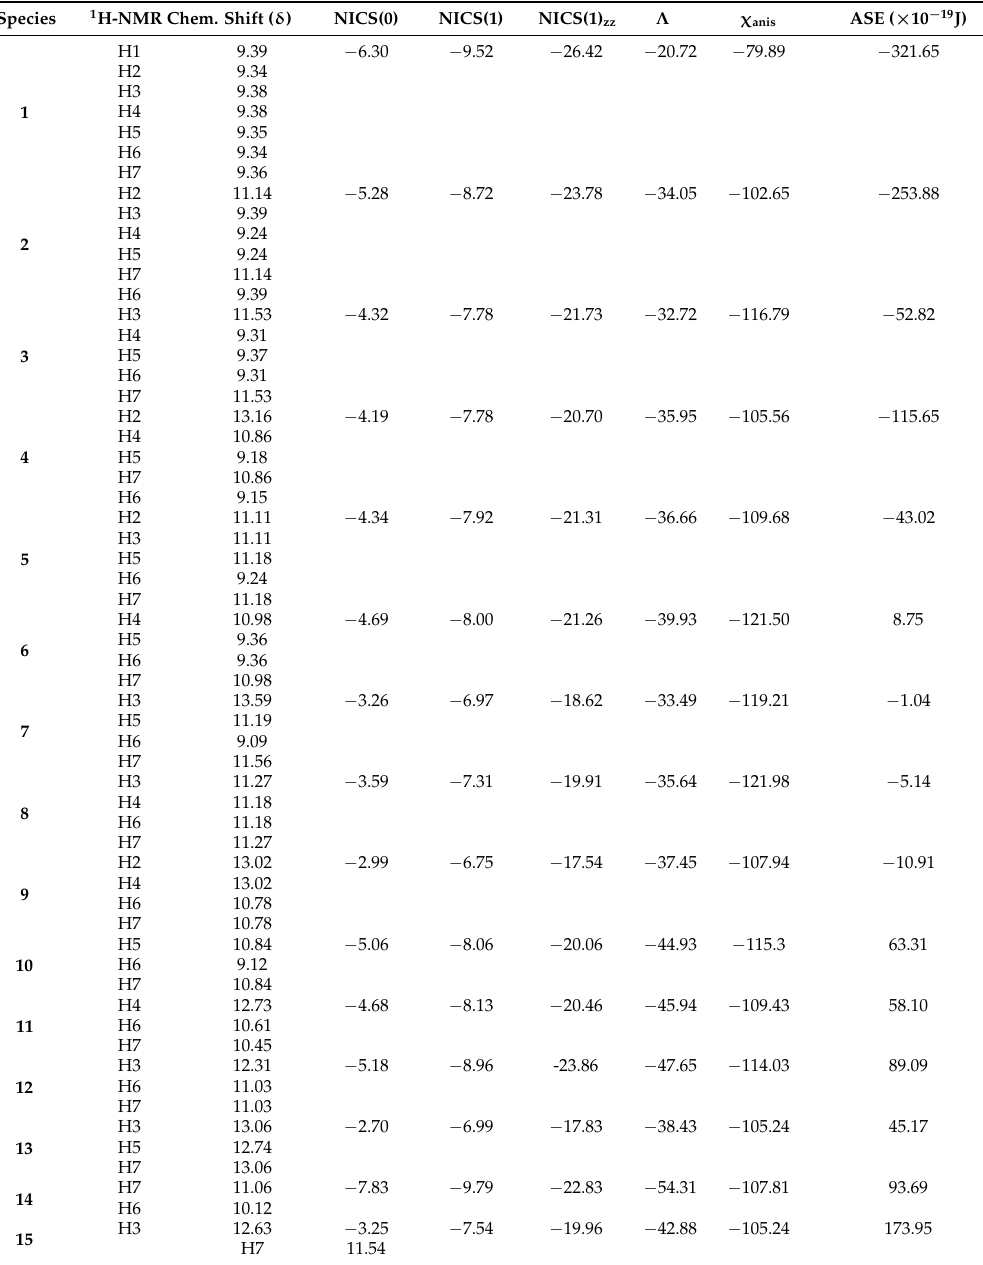
Table 3. 1 H-NMR chemical shifts, nucleus-independent chemical shift (NICS), magnetic susceptibility exaltation, magnetic anisotropy and aromatic stabilization energy ASE values of tropylium ion and its phospha